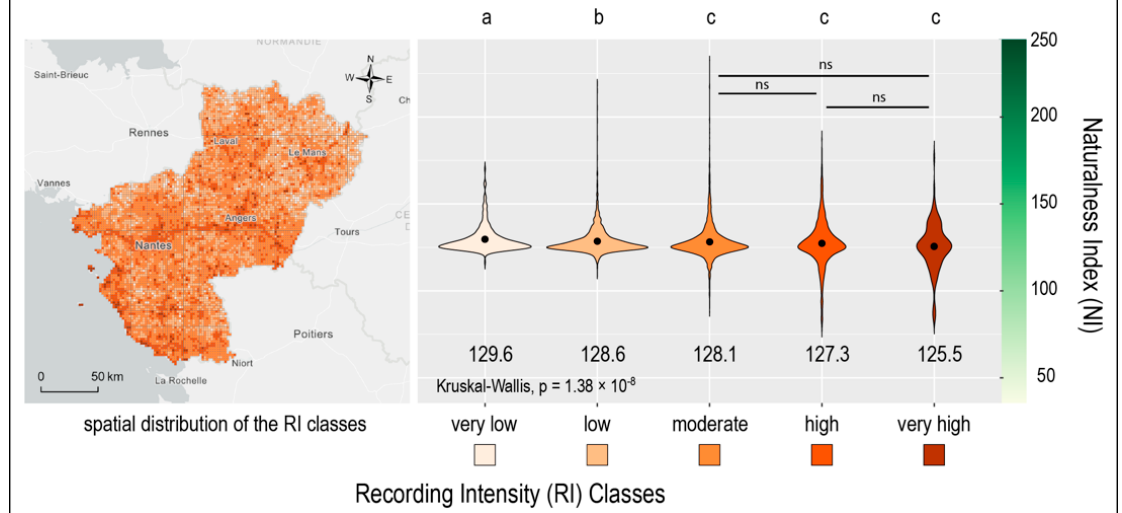
Figure 3. On the left, a map of the spatial distribution of the 5 RI classes, from very low to very high On the right, violin plots of mean NI among RI classes. Shapes of violin represent the kernel density of the NI data. Black points are the mean NI values given in bold type underneath. Significant differences are indicated by letters a–c. Non-significant (ns) differences ( p > 0.05) between classes are denoted by bars.